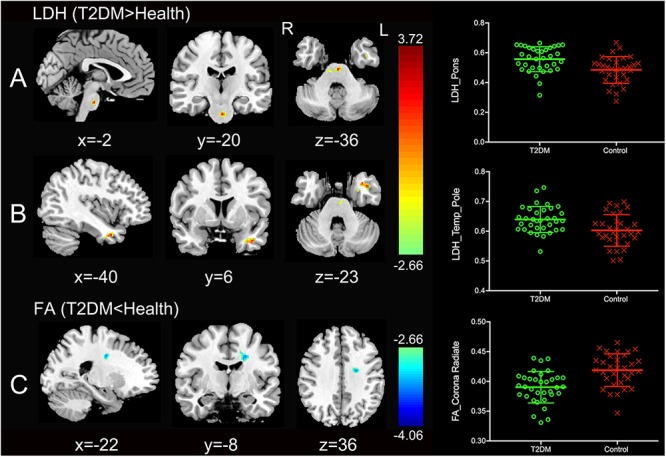
Clusters of between-group differences of LDH and FA with age, gender and education level adjusted (p < 0.05, AlphaSim corrected). Significantly higher regional LDH were found in the pons (A) and the left temporal pole (B), and significantly decreased FA were found in the left superior corona radiate (C) in T2DM subjects compared to the healthy controls. Color scale denotes the t values; x, y, z, Montreal Neurological Institutes coordinates; L, left; R, right. The scatter plots show LDH or FA values (means and SD) extracted from each region of interest (ROI) for each group.